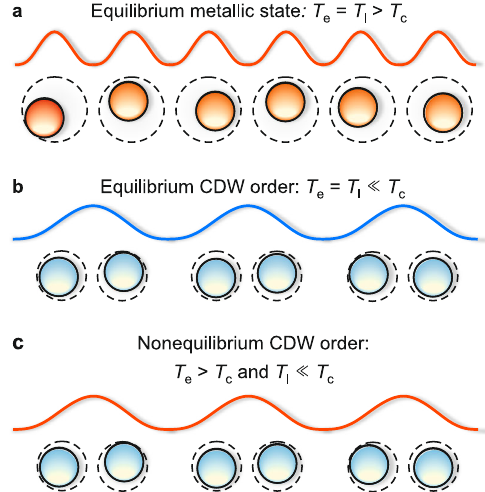
Fig. 5 Illustration of nonthermal CDW order. a In equilibrium at elevated temperatures, the system is in a trivial metallic phase. The charge density (wavy line) and the mean positions of the ionic cores (circles) are spaced evenly, as strong thermal lattice fl uctuations prevent long-range CDW order. b In equilibrium at low temperatures, the system features an ordered charge- and lattice superstructure. c Photoexcitation of the CDW ground state ( T pre (cid:1) exc : (cid:6) T c ) generates a hot electron distribution, while the lattice initially remains cold. In this out-of-equilibrium state, thermal lattice fl uctuations are weak and barely hinder long-range CDW ordering. Hence, the charge and lattice superstructure is stabilized at electronic temperatures beyond T c